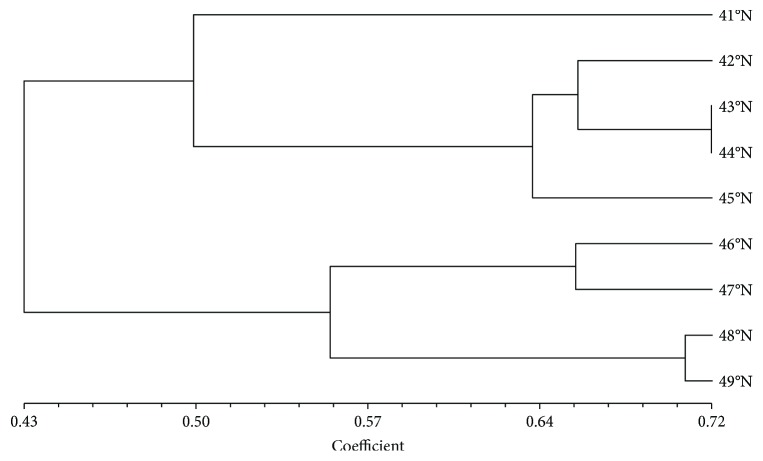
UPGMA dendrogram based on Nei's genetic identity among the latitudes.